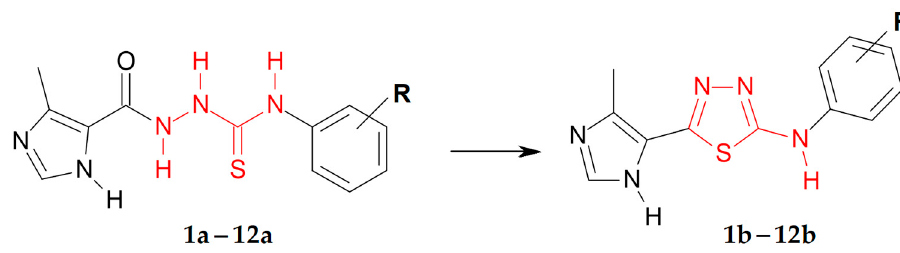
Figure 1. Chemical modifications (red) and structural requirements (black) in this new scaf- fold.